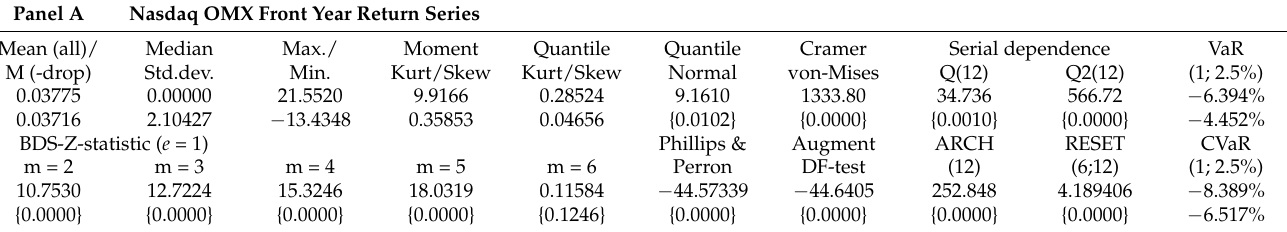
Table 1. Nordic/Baltic Electricity Market Characteristics,